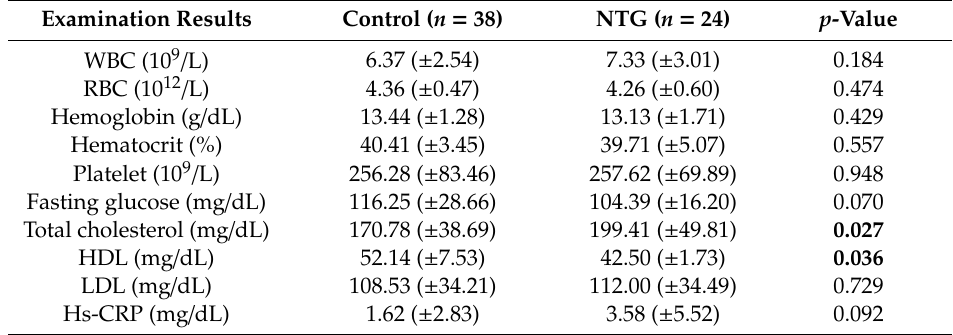
Table 2. Comparison of the blood examination of the control group and the normal tension glaucoma (NTG) group.